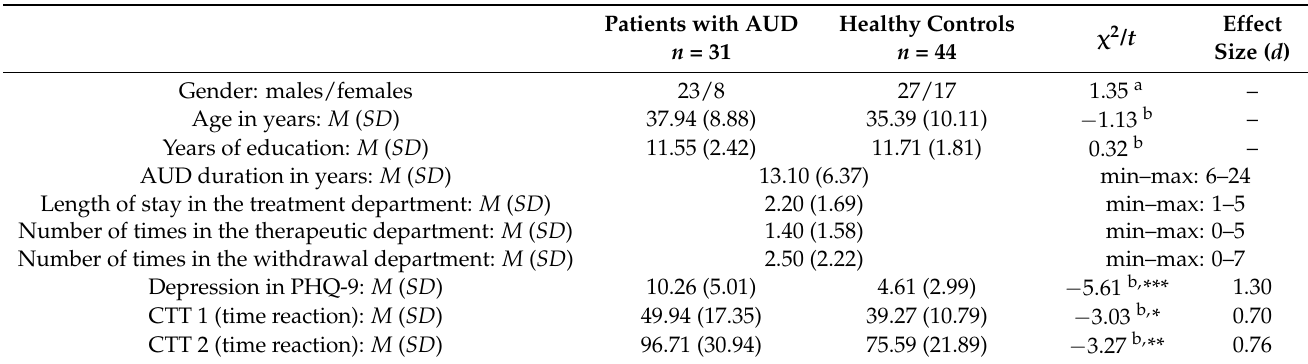
Table 1. Descriptive demographic, clinical, and psychological characteristics of patients with alcohol use disorder (AUD) and healthy controls.